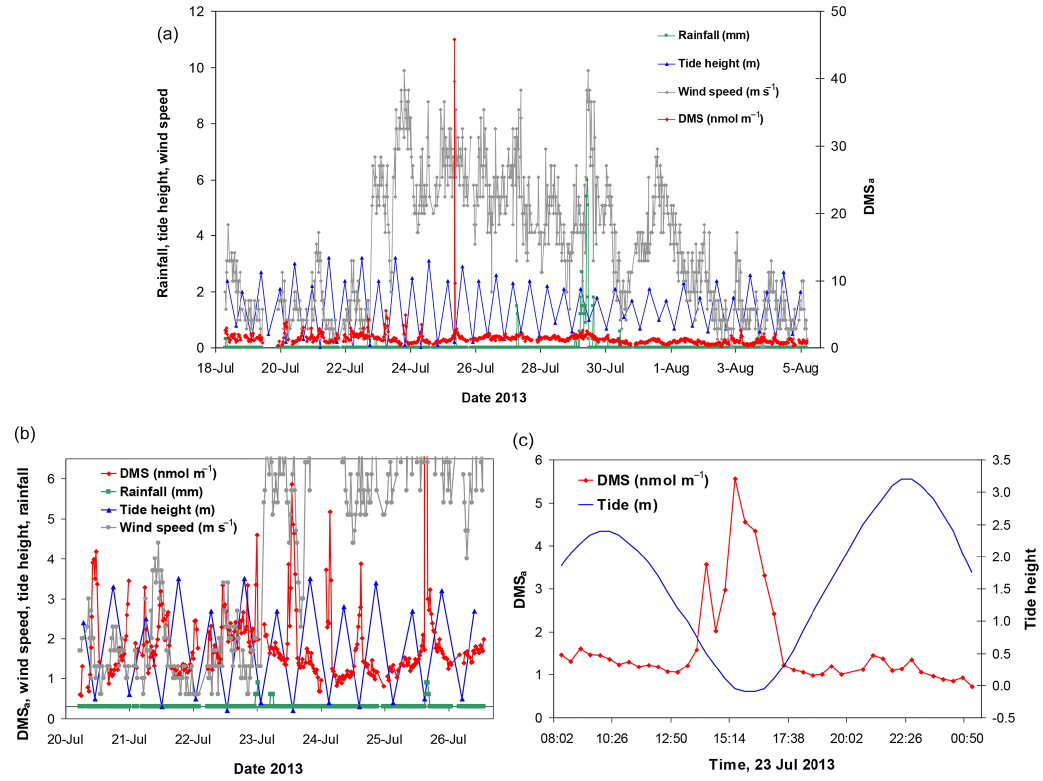
Figure 6. Data obtained from Heron Island during the dry season of 2013. (a) Entire time series of DMS a (red line), WS (grey line), rainfall (green line) and tide height (blue line). The second axis for DMS a is scaled to show the relative intensity of the coral reef DMS a spike (45.9nmolm − 3 ) detected at low tide in the early evening of 25 July. Even under relatively strong atmospheric mixing (WS = 9.5ms − 1 , grey line) this DMS a reef-derived spike was detected as an intense event. (b) Extracted time series from 20 to 26 July showing 10 low-tide coupled DMS a spikes from the Heron Island reef flat. The extreme DMS a spike (off-scale) on 25 July can be seen to be linked to the 0.2m low tide and a brief shower of rain that fell onto the aerially exposed coral reef. (c) Time-line magnification of the low-tide-induced DMS a spike from the Heron Island coral reef on 23 July between 13:31 and 17:28. There was no rainfall during the period